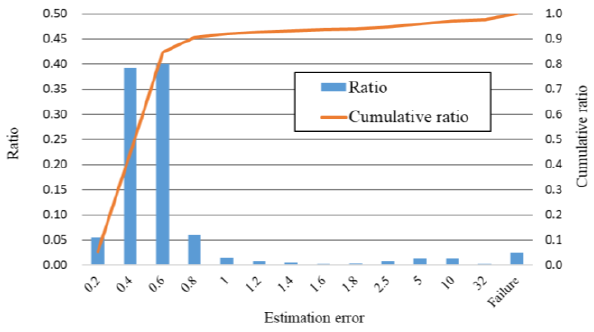
Figure 6. Distribution of estimation error